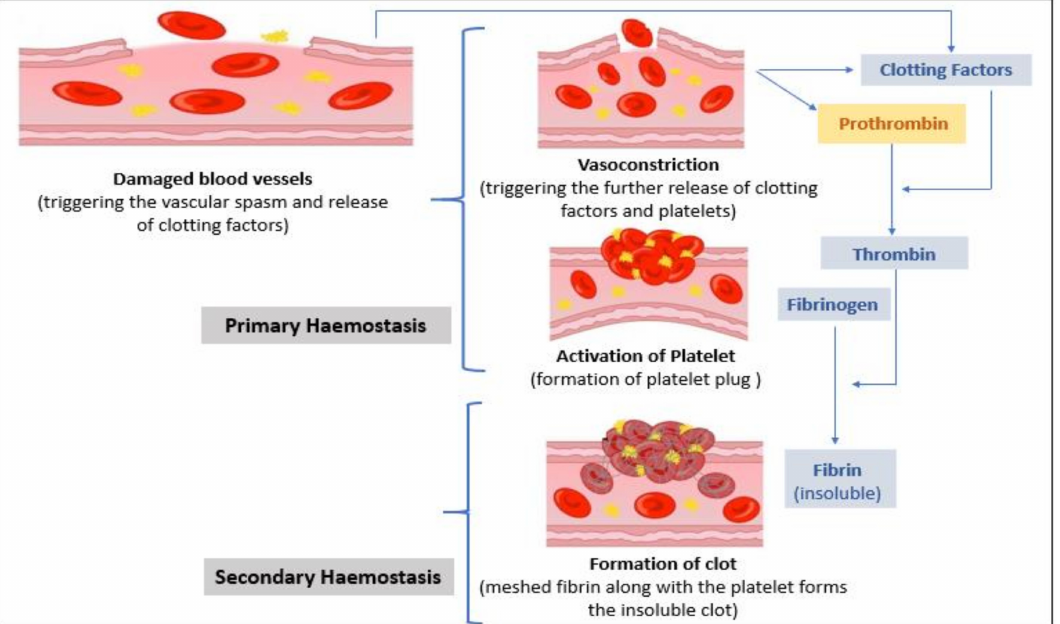
Figure 2. Schematic enunciating stages of